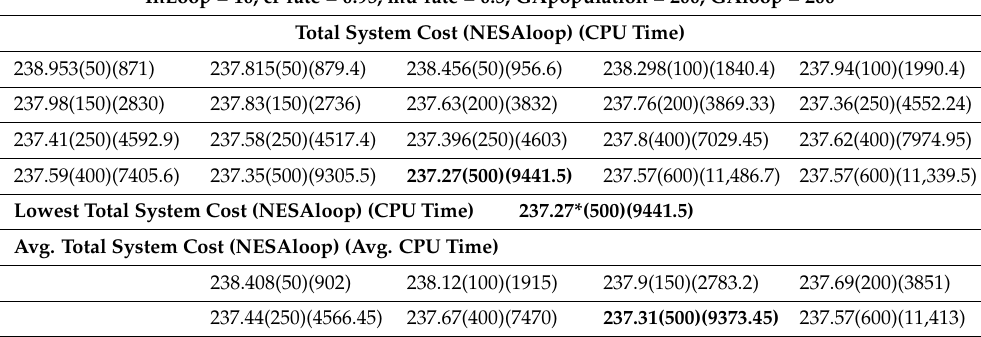
Table 11. The total system costs of 20 simulation runs obtained by NESA–MGA for the n -stage standby